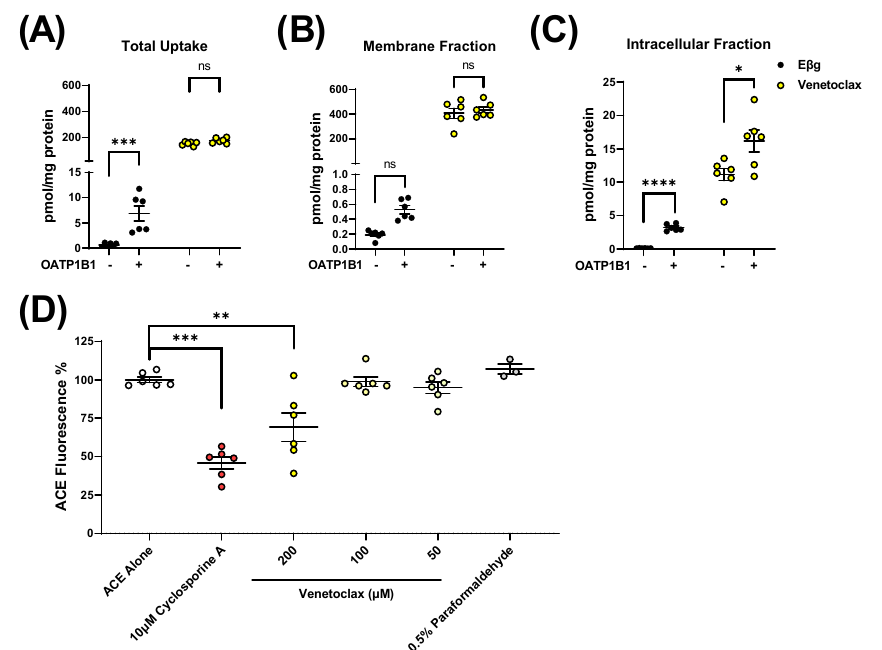
demonstrates that only <3% of venetoclax remains unbound, suggesting that the actual unbound concentration of venetoclax in these experiments was <10 µ M.